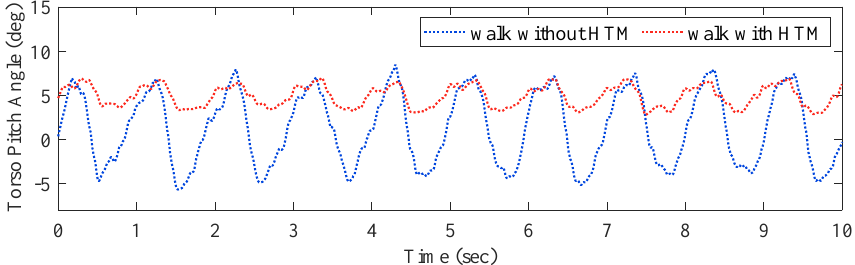
Figure 11. The torso pitch angles when walking with the